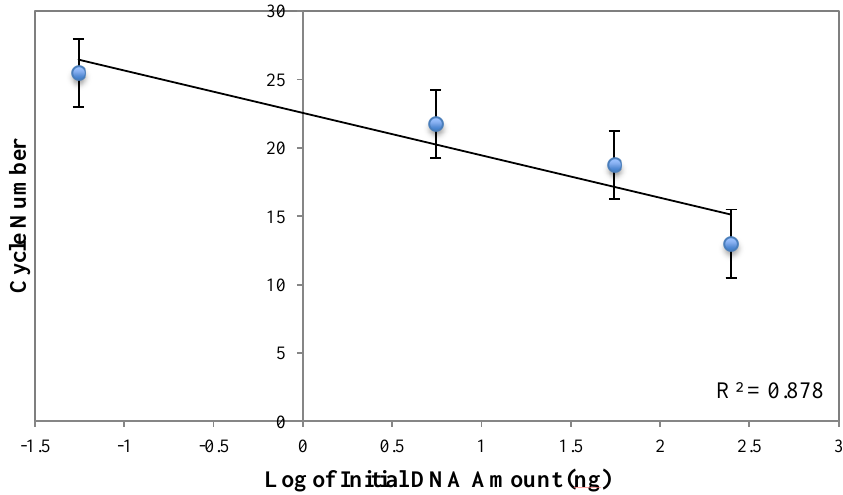
Figure A4. Plot of reaction cycle number versus log of initial DNA amount for the qPCR measurement by AMBR method. Error bars represent the uncertainty due to the AMBR measurement of every five